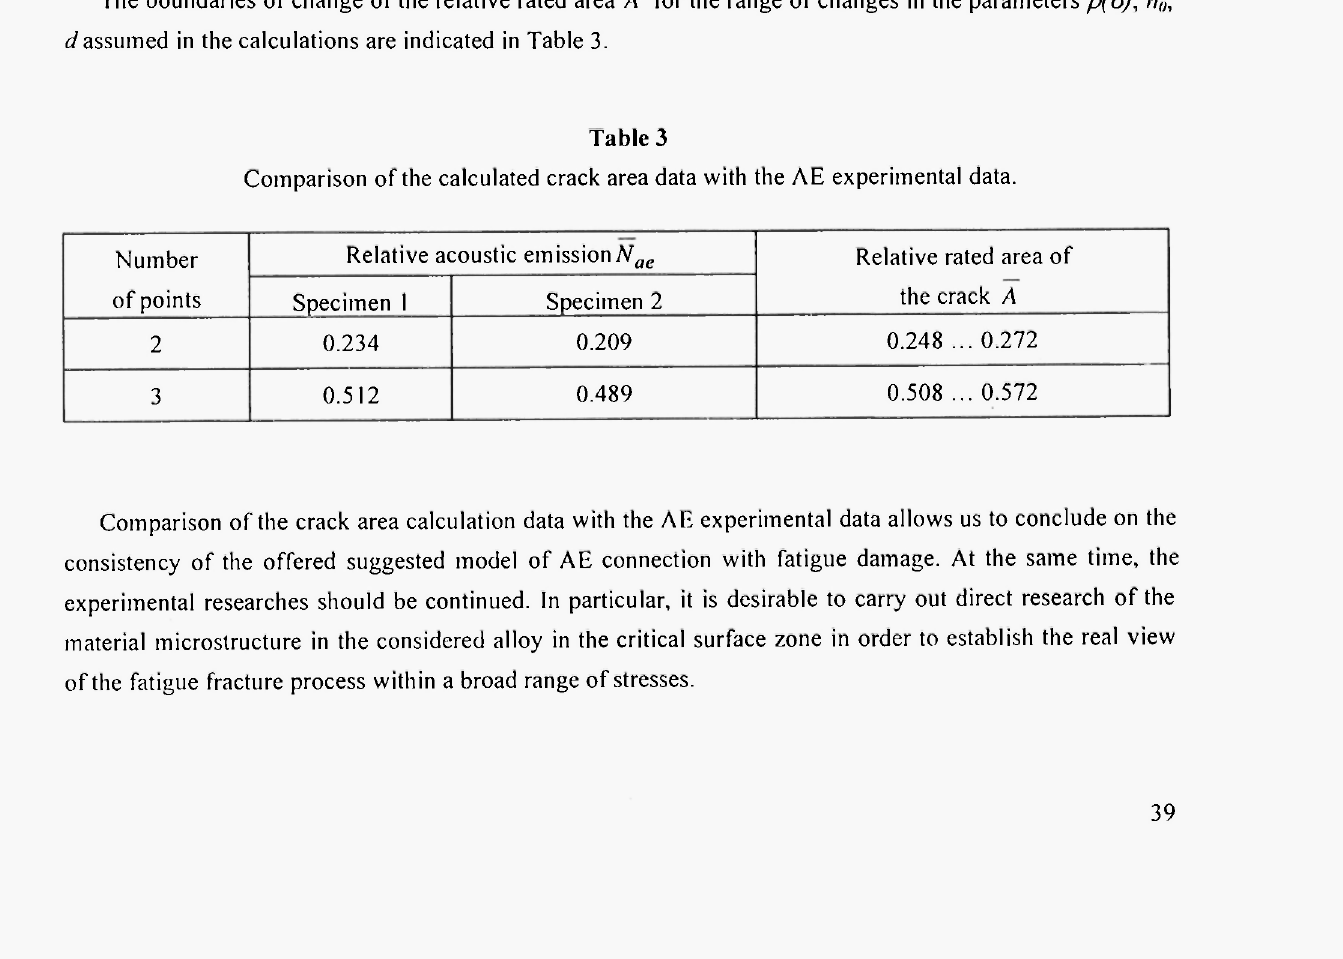
Comparison of the calculated crack area data with the AE experimental